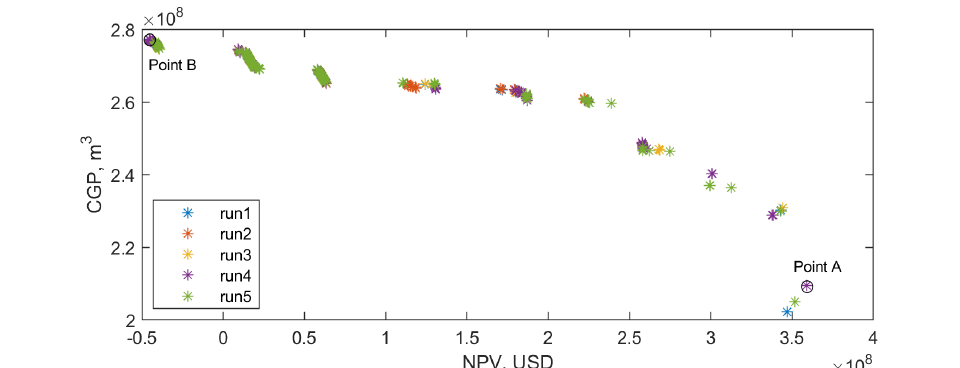
Figure 13. Pareto fronts of 10 independent tests for one random test